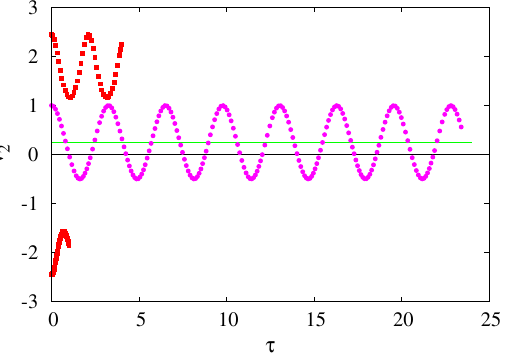
ð (cid:12) Þ versus (cid:12) for a ¼ 1 = 2 , k ¼ 0 , A ¼ 2 as in Fig. 2. FIG. 4. v 2